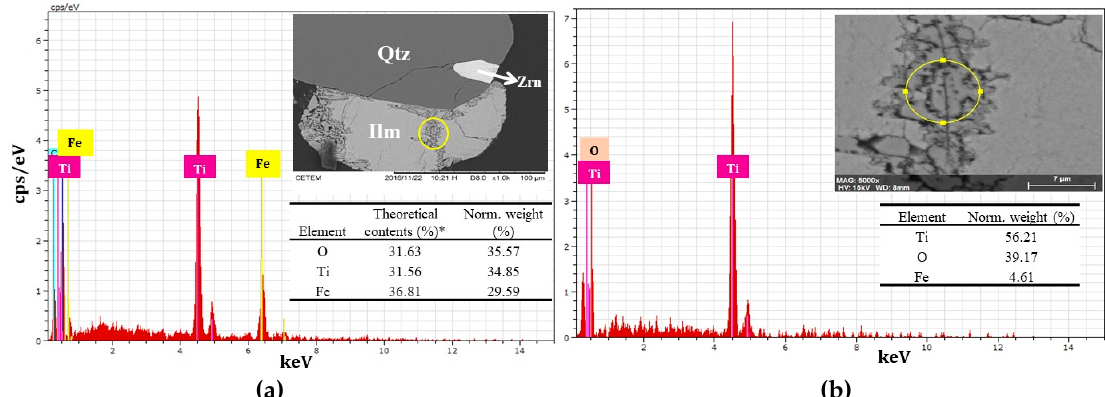
Figure 8. SEM images and EDX results for ilmenite ( a ) and details of its alteration ( b ). * Note: values from Dana (1974) [39].